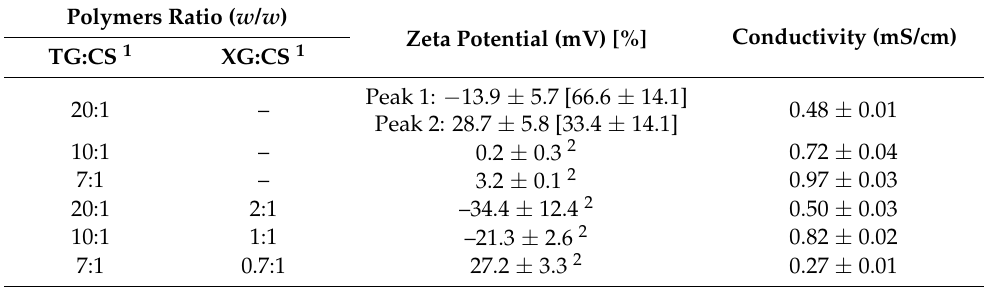
Table 3. Zeta potential and conductivity of the di- and tripolymeric dispersions (mean ± SD, n = 3). Polymers Ratio ( w/w